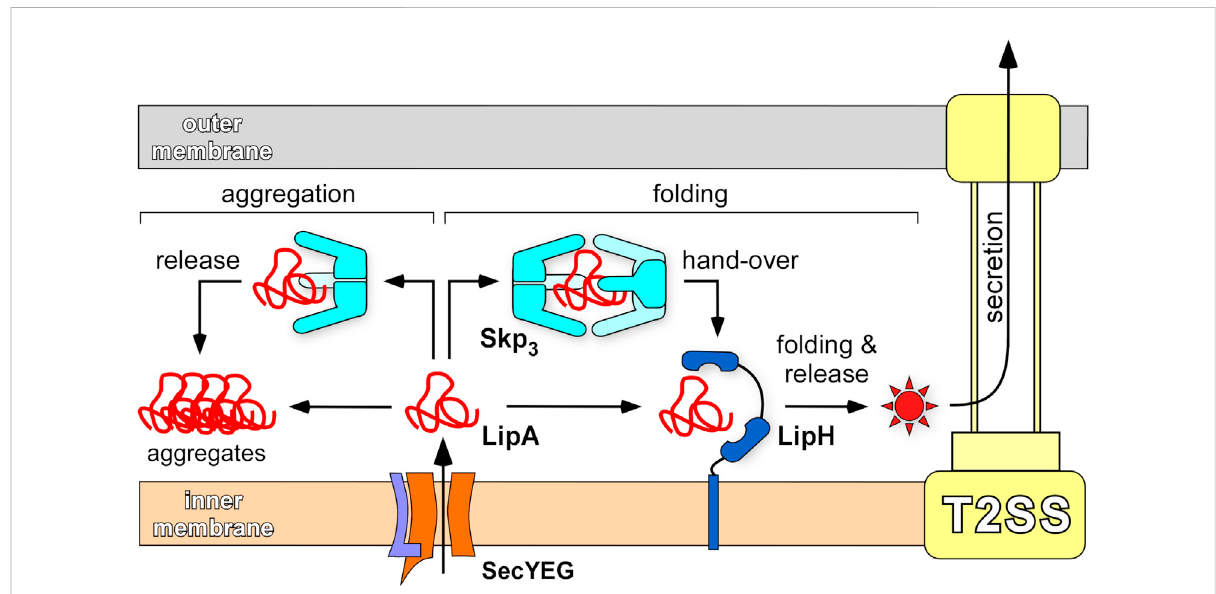
FIGURE 9 Chaperone-assisted folding of LipA in the periplasm. After the initial translocation via SecYEG complex into the periplasm, the aggregation- proneLipAmaybedirectlypickedupbythefoldaseLipH,acquirethenative,enzymaticallyactivestructure(indicatedasaredstar)andbetransferred to the type II secretion machinery (T2SS). Alternatively, LipA may interact with the abundant trimeric chaperone Skp 3 that prevents LipA from aggregation, when a complex at 1:2 stoichiometry is formed. Upon its release, LipA may bind LipH and proceed along the folding/secretion pathway. A single copy of Skp 3 does not ensure the holdase function and does not rescue LipA from